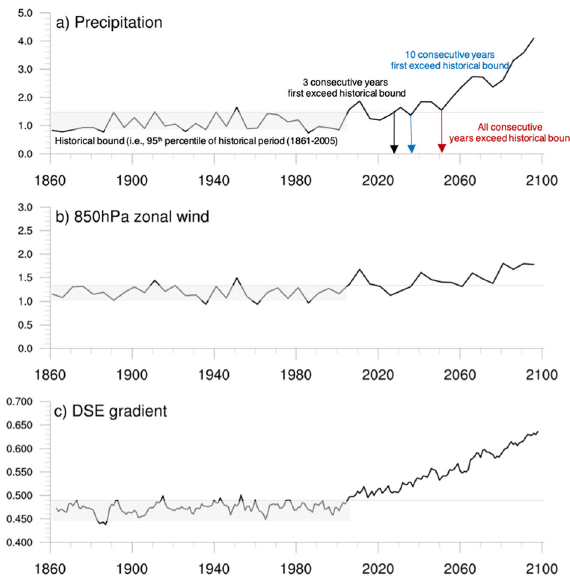
Fig. 2 Estimating the projected timing of MJO amplitude. a MJO precipitation amplitude (units are mm/day), b 850 hPa zonal wind amplitude (units are m/s), and c vertical dry static energy (DSE) gradient integrated from 400 – 600 hPa (units are J/kg/Pa). Also indicated are the times of emergence relative to the historical bound (gray area). Fields are shown for one example member (i.e., cmip6.1251.002) at 5°S and 110°W (small blue dot in Fig. 1a). A similar plot for 5°S and 70°E is shown in Supplementary Figure